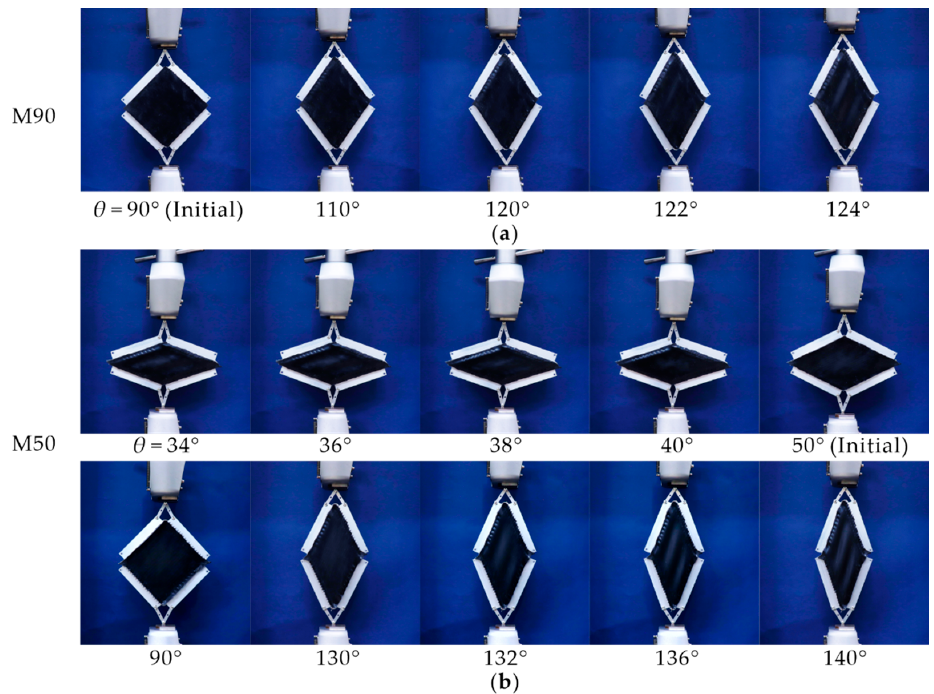
Figure 4. Deformation processes of the specimens: ( a ) M90; ( b ) M50.